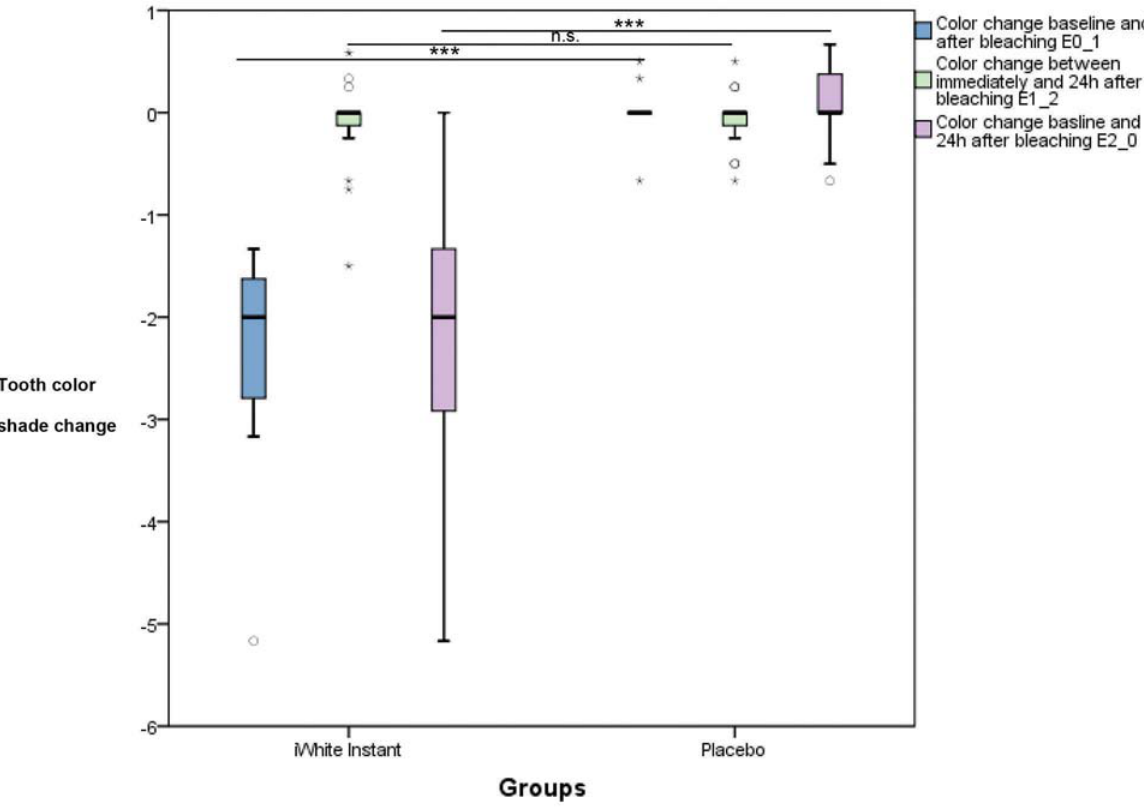
Figure 5- Values of the color change for bleaching and placebo groups between baseline and immediately after bleaching, between (cid:76)(cid:80)(cid:80)(cid:72)(cid:71)(cid:76)(cid:68)(cid:87)(cid:72)(cid:79)(cid:92)(cid:3)(cid:68)(cid:81)(cid:71)(cid:3)(cid:21)(cid:23)(cid:3)(cid:75)(cid:3)(cid:68)(cid:73)(cid:87)(cid:72)(cid:85)(cid:3)(cid:69)(cid:79)(cid:72)(cid:68)(cid:70)(cid:75)(cid:76)(cid:81)(cid:74)(cid:15)(cid:3)(cid:68)(cid:81)(cid:71)(cid:3)(cid:69)(cid:72)(cid:87)(cid:90)(cid:72)(cid:72)(cid:81)(cid:3)(cid:69)(cid:68)(cid:86)(cid:72)(cid:79)(cid:76)(cid:81)(cid:72)(cid:3)(cid:68)(cid:81)(cid:71)(cid:3)(cid:21)(cid:23)(cid:3)(cid:75)(cid:3)(cid:68)(cid:73)(cid:87)(cid:72)(cid:85)(cid:3)(cid:69)(cid:79)(cid:72)(cid:68)(cid:70)(cid:75)(cid:76)(cid:81)(cid:74)(cid:3)(cid:81)(cid:17)(cid:86)(cid:17)(cid:3)(cid:11)(cid:81)(cid:82)(cid:87)(cid:3)(cid:86)(cid:76)(cid:74)(cid:81)(cid:76)(cid:191)(cid:70)(cid:68)(cid:81)(cid:87)(cid:12)(cid:30)(cid:3)(cid:13)(cid:13)(cid:13)(cid:3)(cid:11)(cid:83)(cid:31)(cid:19)(cid:17)(cid:19)(cid:19)(cid:20)(cid:12)